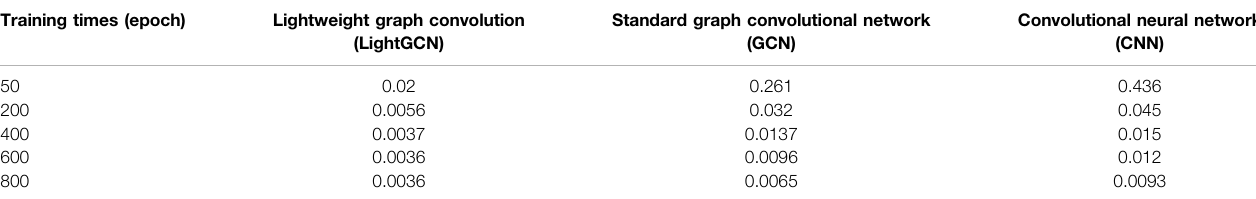
TABLE 2 | Training loss comparison.